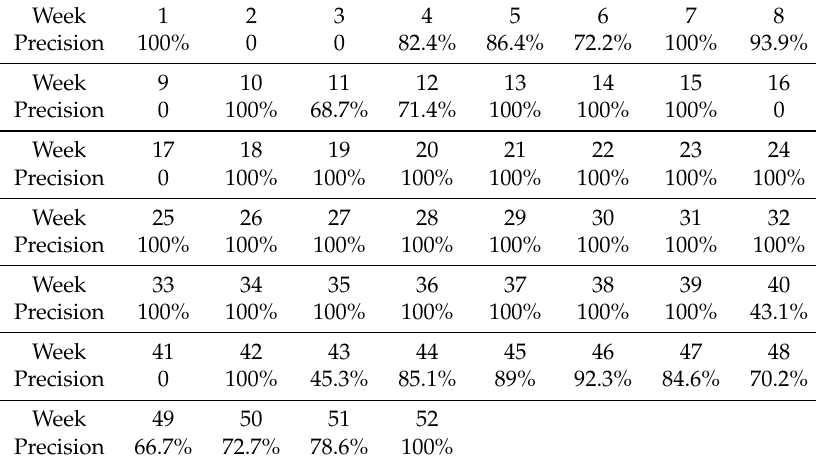
Table A1. The precision of anomaly detection results for the weekly data of School